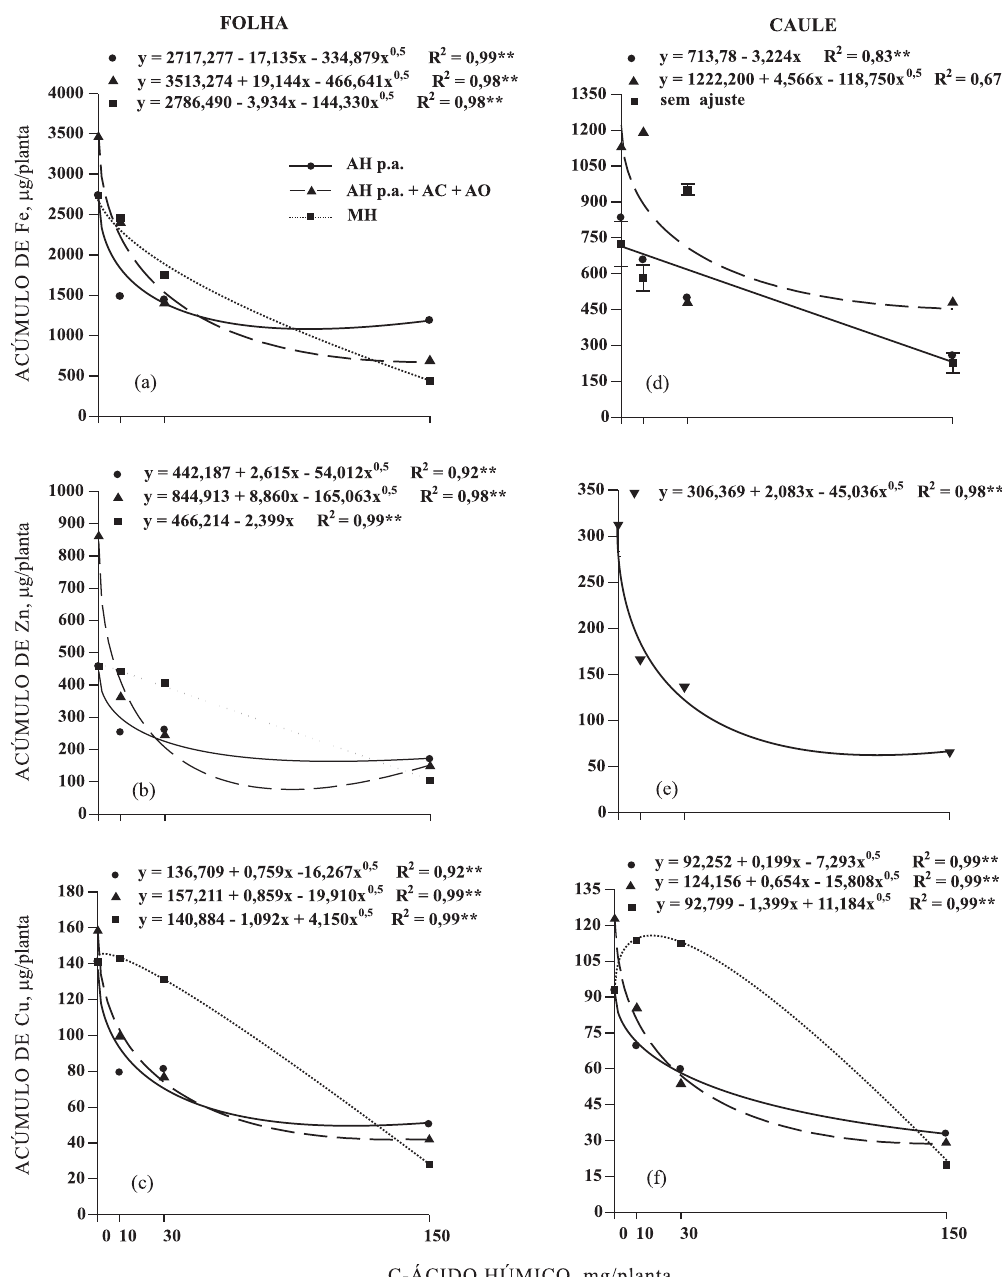
Figura 7. Acúmulo de Fe, Zn e Cu na matéria seca das folhas (a, b, c) e do caule (d, e, f) de mudas de eucalipto em resposta ao aumento de concentrações de C-AH em solução nutritiva. AH p.a.: ácido húmico p.a.; MH: material húmico; AC: ácido cítrico; AO: ácido